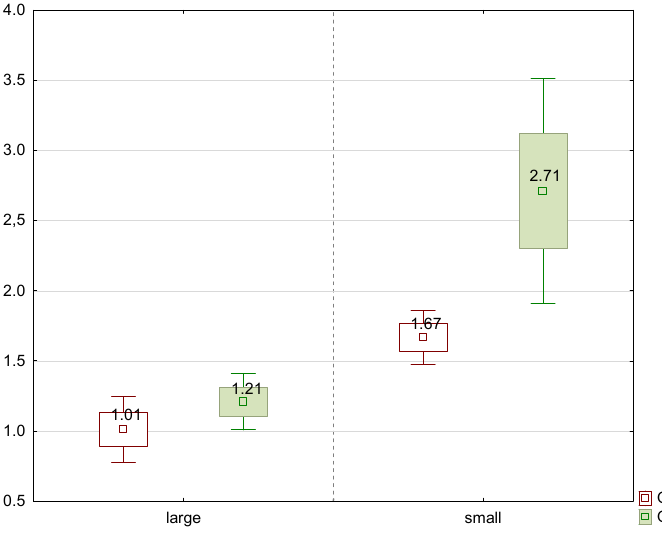
Risks 2022 , 10 , x FOR PEER REVIEW